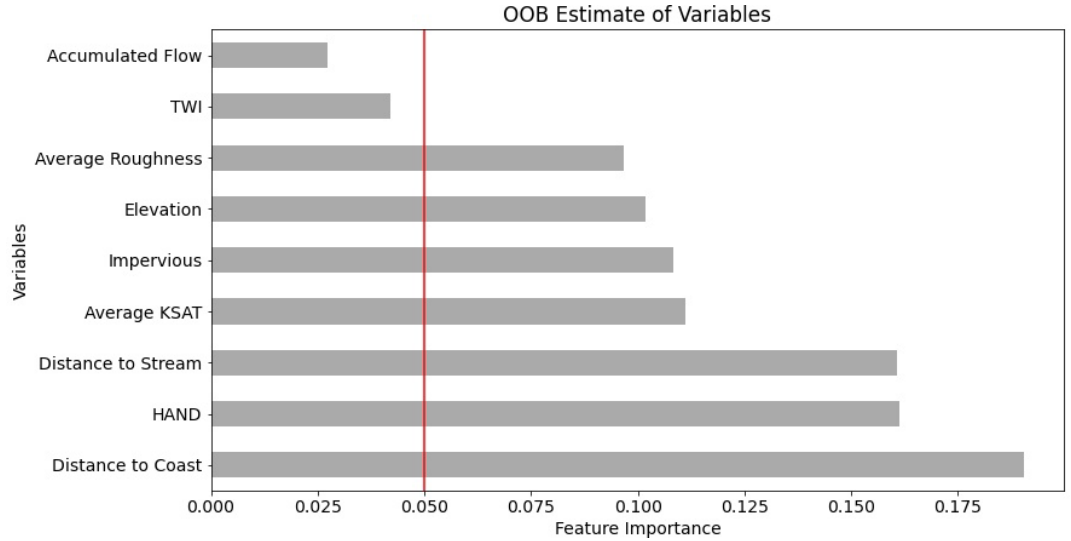
Figure 3. Feature importance chart. Note that variables below 0.05 were removed from the final model. The red line denotes the cutoff value for the final